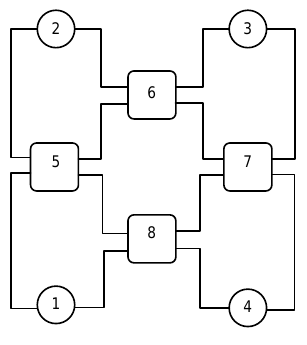
Figure 3. An HSR sample